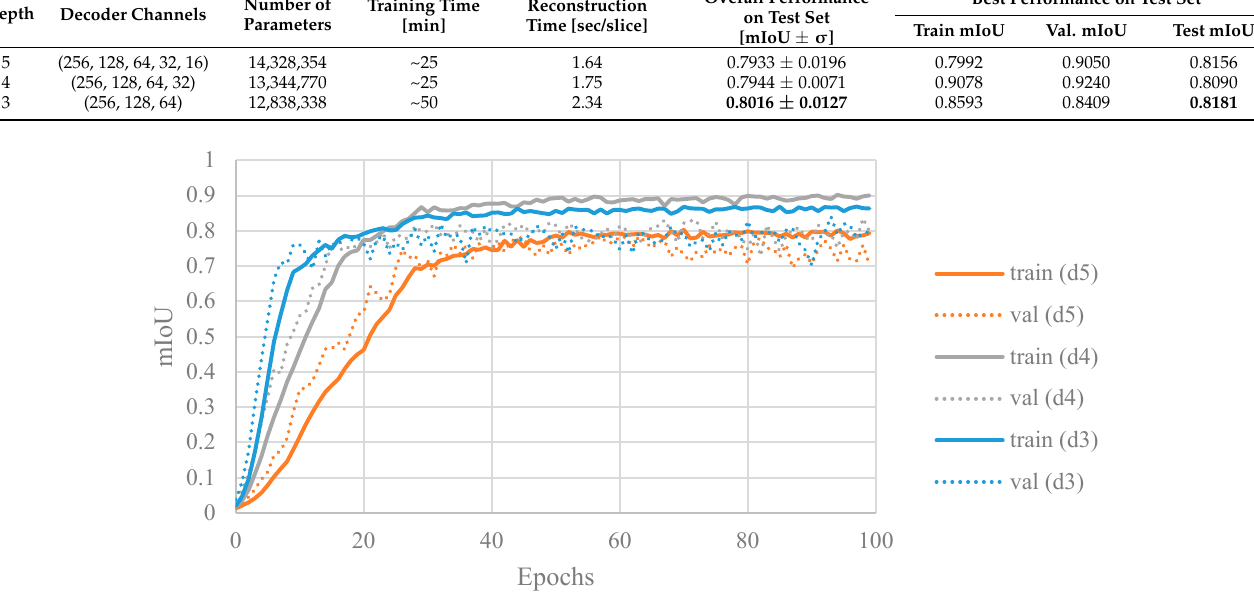
Figure 10. Training and validation evolution for each depth. The shallow network can converge faster than deeper networks.